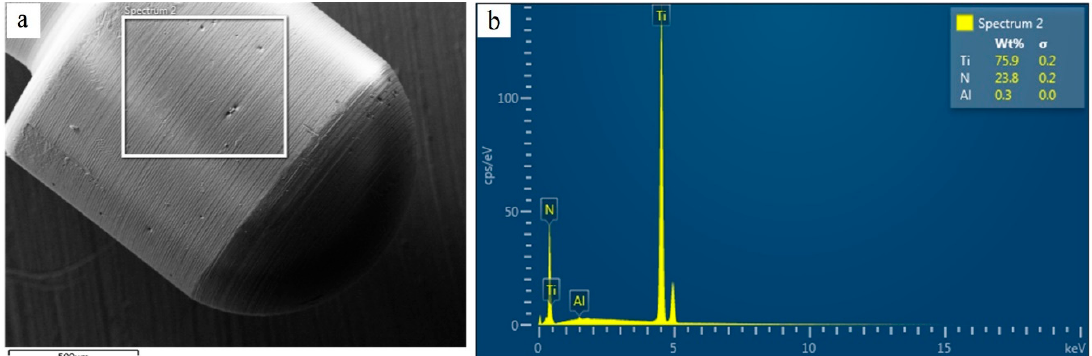
Figure 2. ( a ) Scanning electron microscope (SEM) image of the coated electrode. The indicated region is the area over which EDX was performed. The scale-bar is 500 µm. ( b ) Typical energy dispersive X-ray spectroscopy (EDX) spectrum corresponding to the area indicated in ( a ).